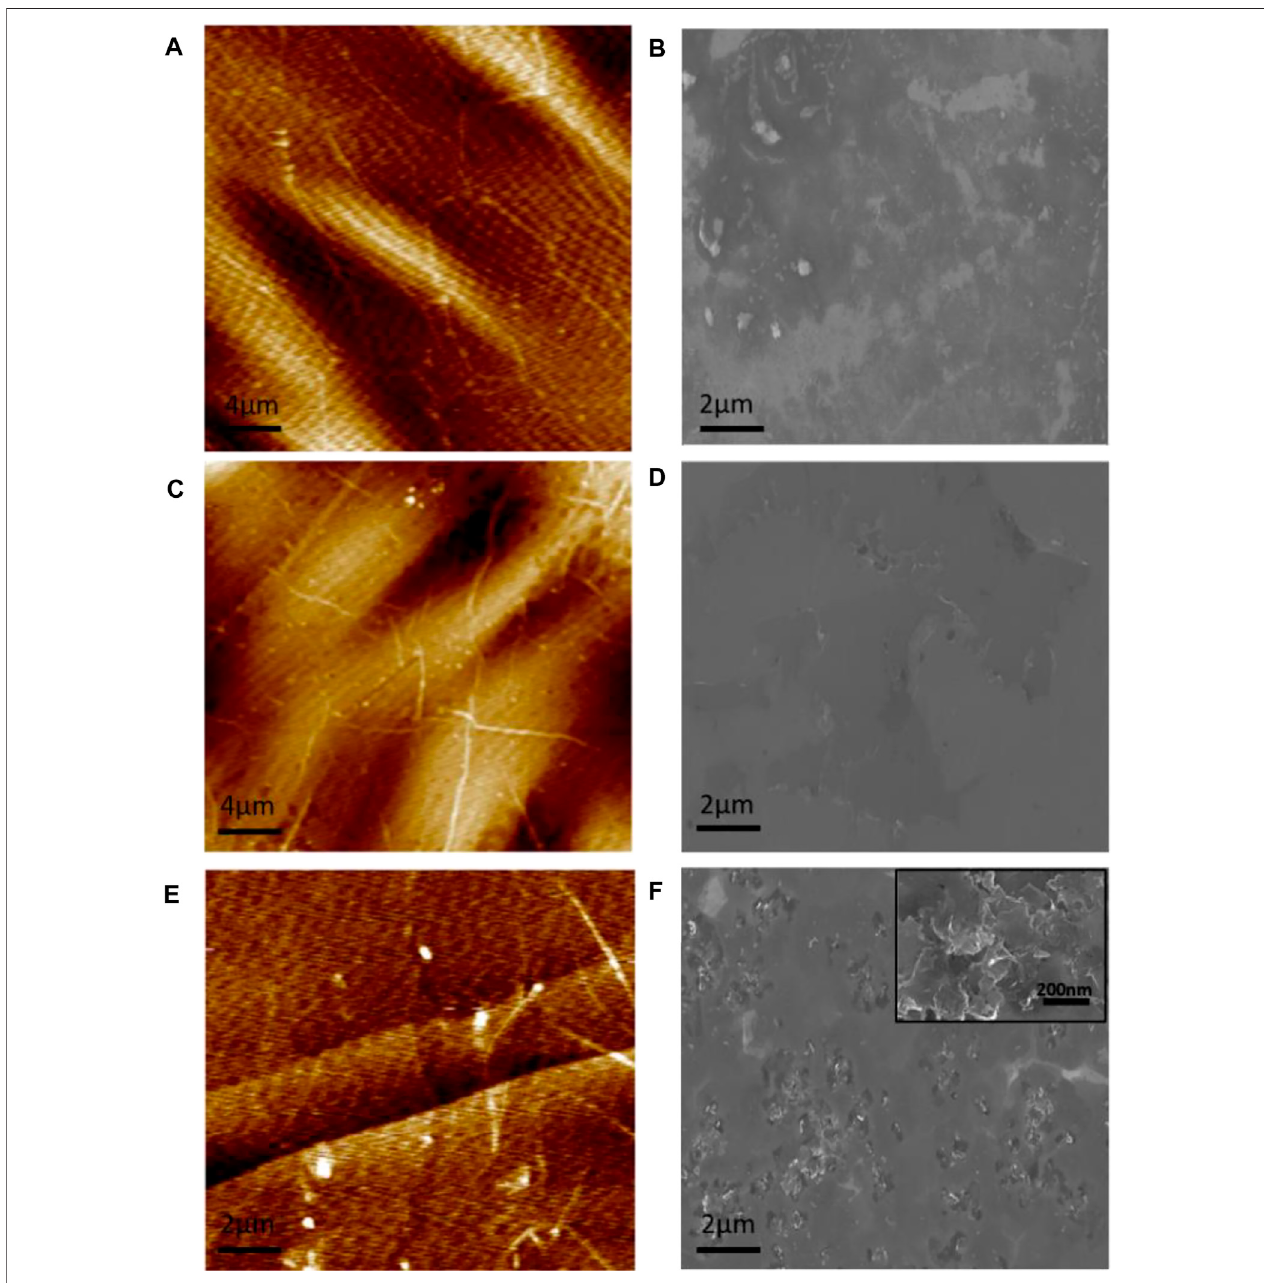
FIGURE 1 | AFM and SEM images of (A,B) are for the single-layer graphene (S1) and (C,D) are for bilayer graphene (S2), both prepared by the transferred graphene. (E,F) are the AFM and SEM images of bilayer graphene (S3) prepared by the decomposition of SiC, respectively.